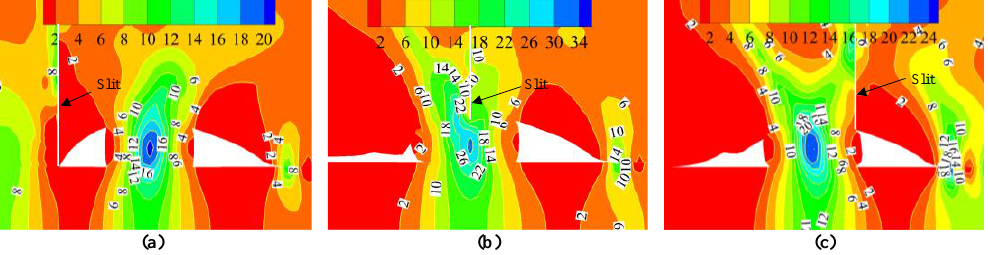
Figure 9. Nephogram of vertical stress distribution of surrounding rock at different top cutting po- sitions: ( a ) working face side; ( b ) above coal pillar; ( c ) gob side.